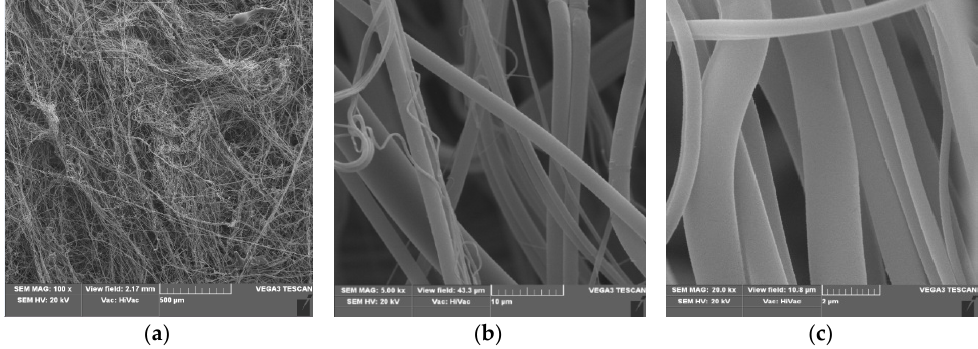
Figure 2. SEM result of Polylactide nonwoven (PLA), magnification 100 × ( a ), 5000 × ( b ) and 20,000 × ( c ).